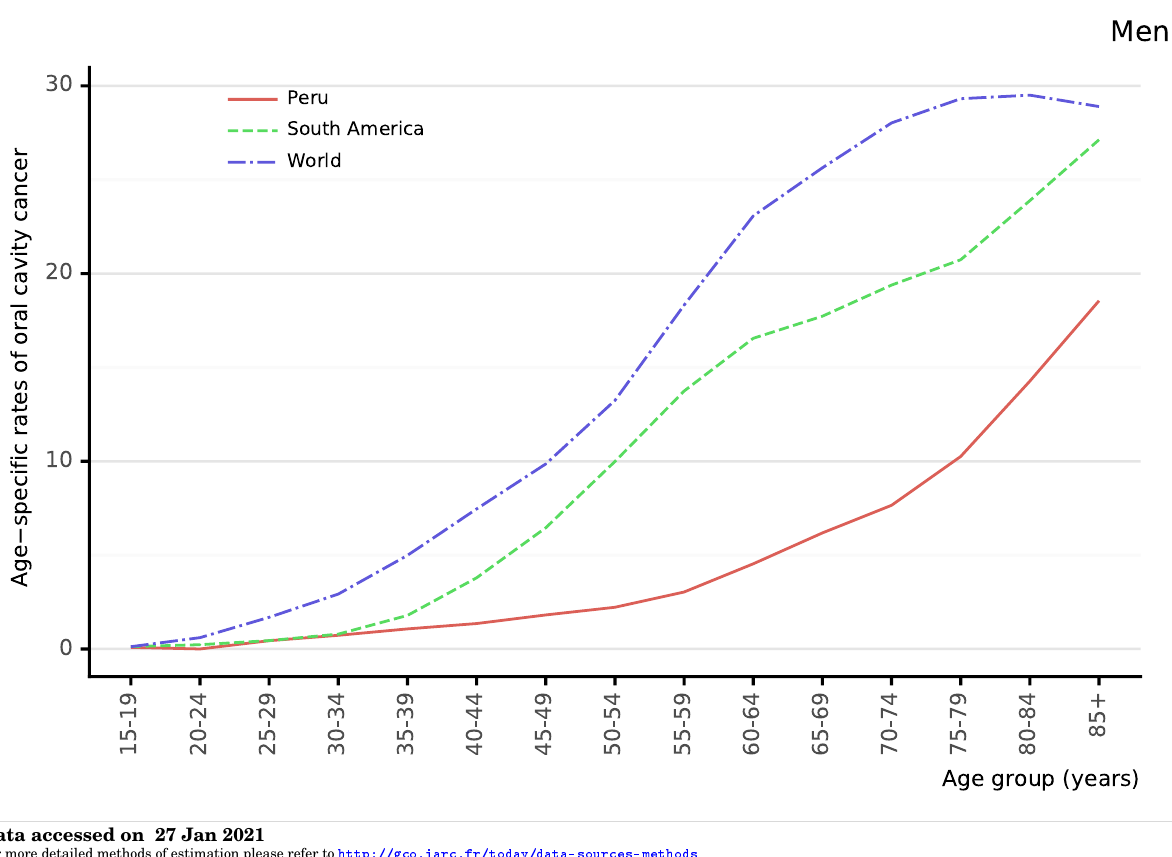
Figure 98: Comparison of age-specific oral cavity cancer incidence rates among men by age in Peru, within the region, and the rest of